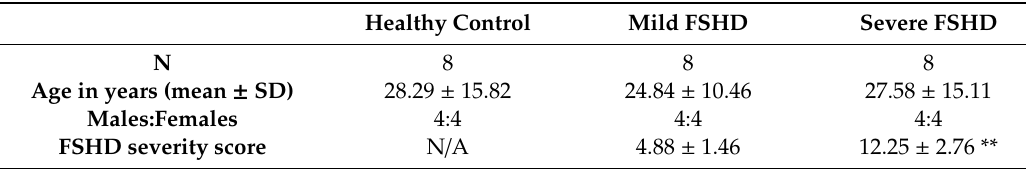
Table 1. Clinical characteristics of study group patients.